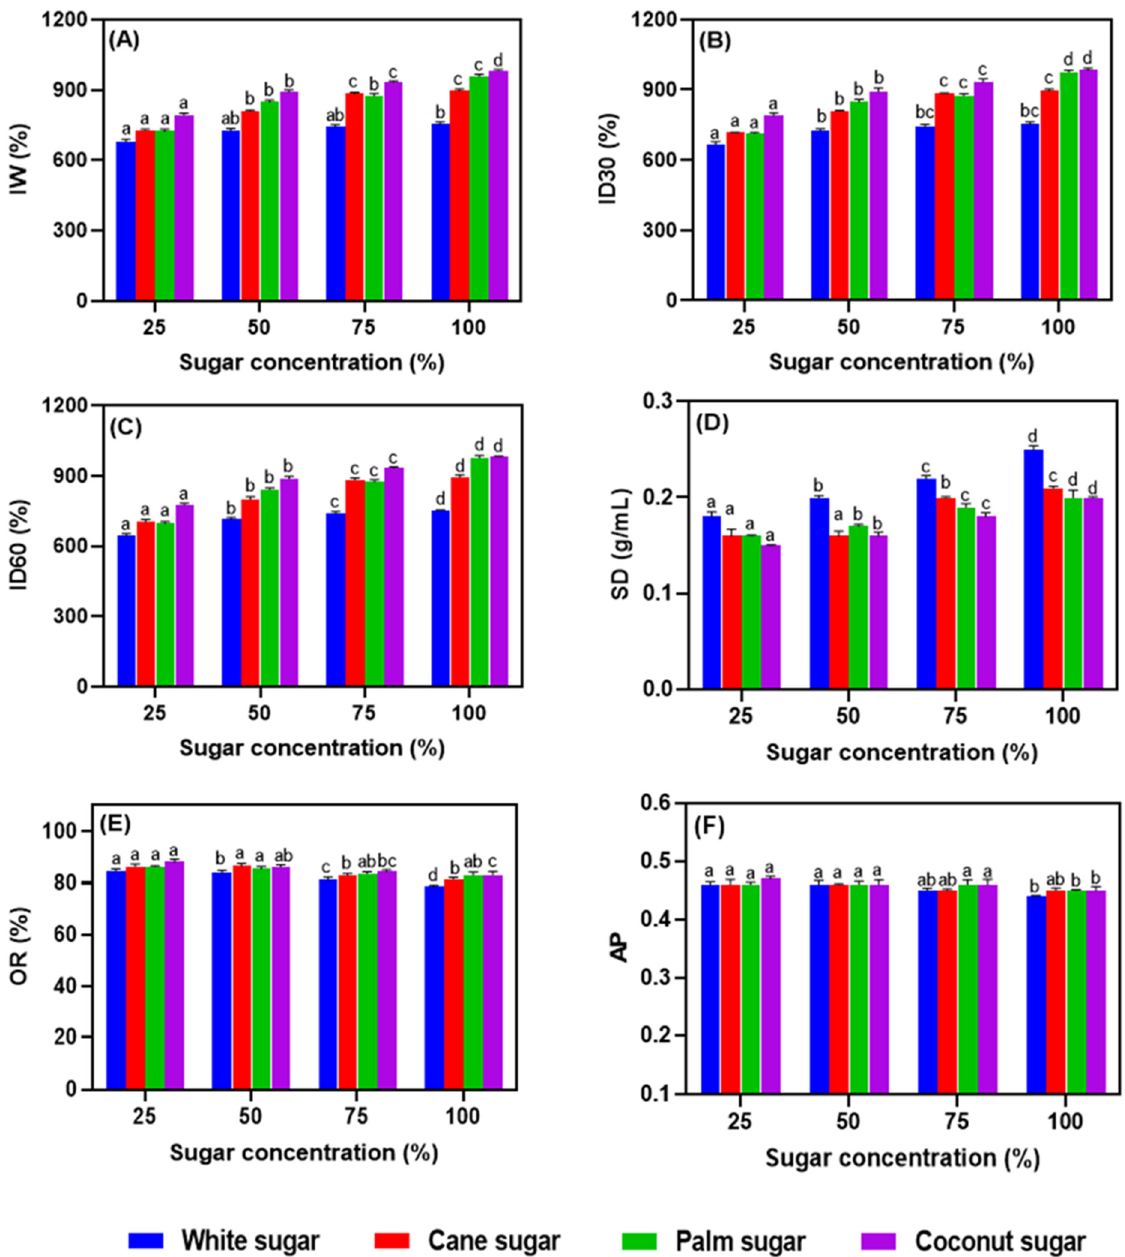
Figure 1. Functional properties ( A – F ) of salted duck egg white foam prepared with alternative types of sugar at various levels in the formulation. Note: IW stands for index of whipping, ID stands for index of foam durability, SD stands for specific density, OR stands for overrun, and AP stands for air phase. Different alphabets above the bars indicate significant differences among various condi ‐ tions.